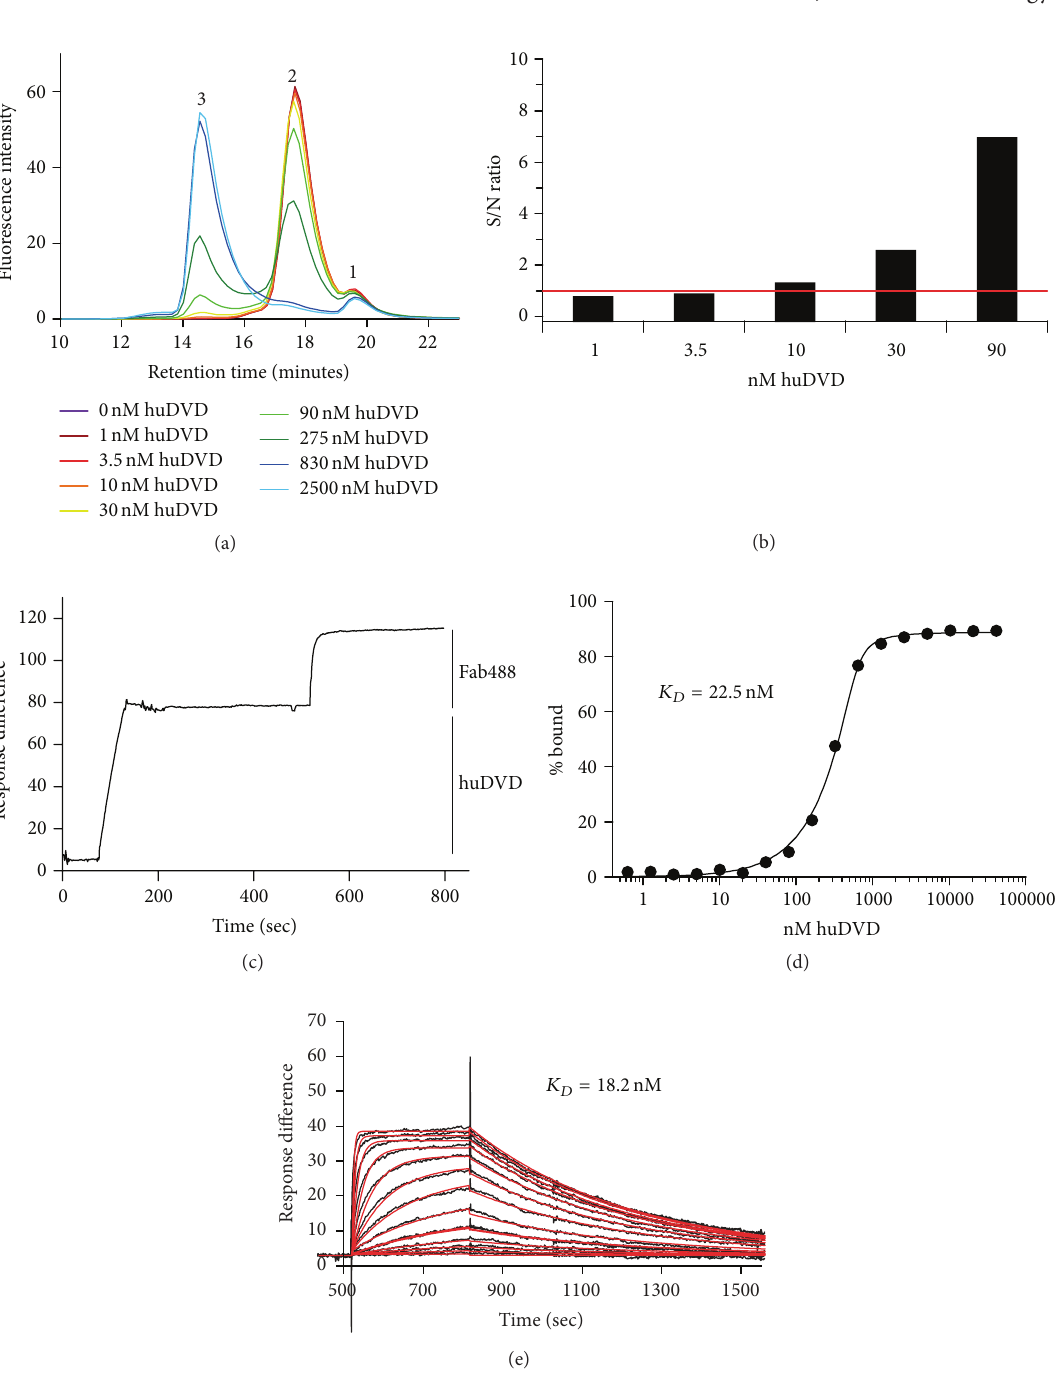
Figure 2: (a) Titration of huDVD on Fab488. 678 nM Fab488 and 1–2500 nM huDVD were incubated in 20% cynoserum as described in Section 2 and separated by size exclusion chromatography with fluorescence detection. Peak 1 is the free dye (DyLight 488), peak 2 is Fab488, and peak 3 is the complex of Fab488 and huDVD. (b) Determination of sensitivity. The signal to noise ratio ( 𝑆/𝑁 ratio) of peak 3 was determined by dividing the percentage of the peak area of peak 3 in runs containing huDVD by the corresponding percentage of peak area at the same retention time of a control run containing no huDVD. (c) Stoichiometry. SPR signal showing the binding of huDVD to anti-human IgG Fc coated CM5 chip (0–200 sec) and the binding of Fab488 at saturation (500–800 sec). The average binding of huDVD was 78 response units and that of Fab488 37 response units (200000 and 47150 Da). (d) 𝐾 𝐷 of the binding of Fab488 to huDVD in 20% cynoserum determined by SEC. The % bound was calculated from the area of peak 3 as compared to total fluorescence as shown in experiment (a), plotted versus the concentration of huDVD, and fitted to the specific binding equation as described in Section 2 to determine the equilibrium dissociation constant ( 𝐾 𝐷 ). (e) 𝐾 𝐷 of the binding of Fab488 to huDVD determined by SPR. Association (500–800 sec) and dissociation (800–1500 sec) of Fab488 (0.49–2000 nM) to and from huDVD bound to an anti-human IgG coated chip. The data points (black curve) were fitted to a 1:1 Langmuir binding model (red